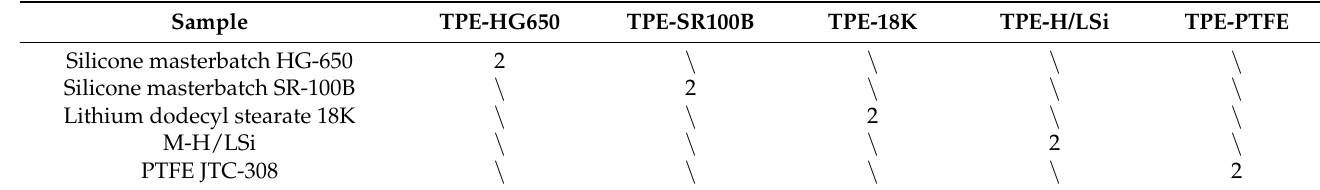
Table 11. Formulas of various lubricating agents and masterbatches.